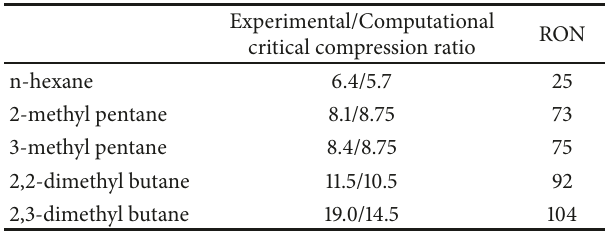
Table 5: Experimentally and numerically predicted values for critical compression ratios of hexane isomers [51].